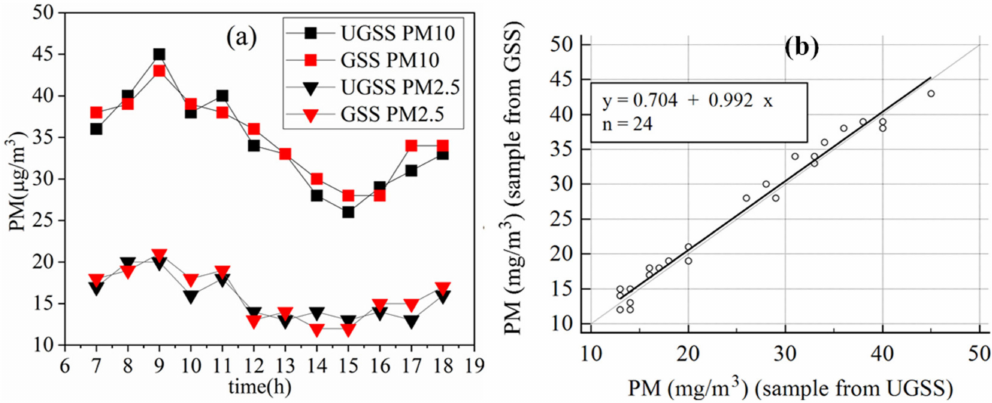
Figure 9. In graph ( a ): the PM2.5 / 10 concentrations collected by the UGSS and concentrations recorded by PM sensor at GSS. In graph ( b ): Deming regression analysis of the PM2.5 / PM10 concentration sample from UGSS vs.